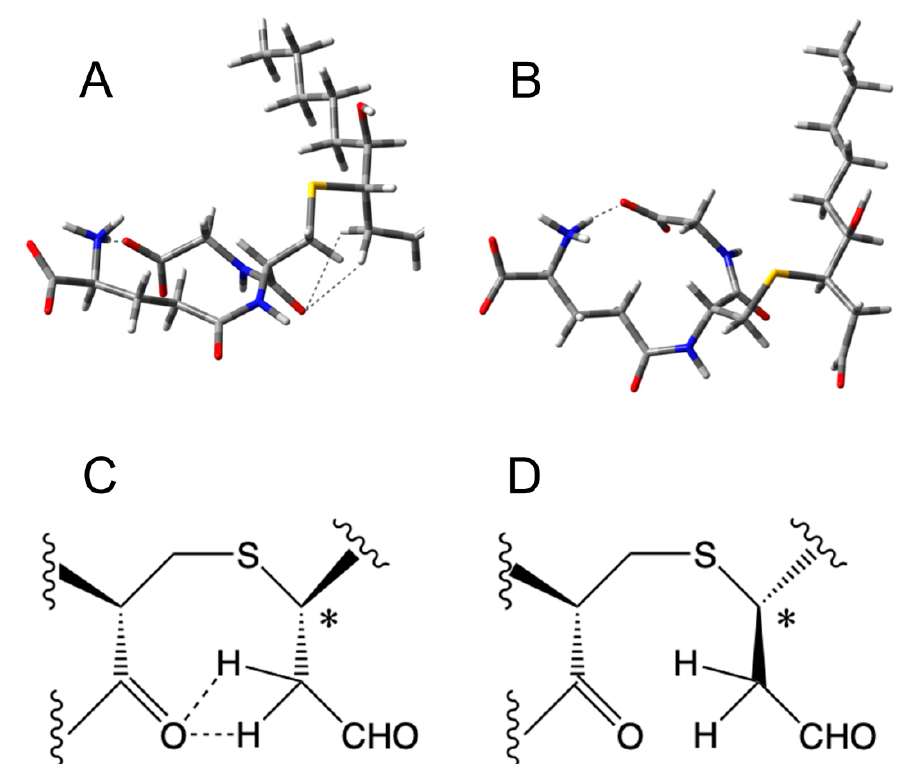
Figure 4. Structure of the open forms of GSHNE diastereoisomers. ( A ) The structure of 3 S ,4 R-GSHNE . The interactions between glutathione amino- and carboxyl-terminals and between the C2 acidic protons of the nonanal portion and the one amidic group of the glutathione moiety are shown. ( B ) The structure of 3 R ,4 R -GSHNE. The interaction between glutathione amino- and carboxyl-terminals is shown. ( C,D ) The di ff erent configurations of the chiral center (*) allow intramolecular hydrogen bonding when the involved groups are on the same side of the plane for 3 S ,4 R-GSHNE ( C ), and prohibit bonding when the involved groups are on opposite sides of the plane for 3 R ,4 R -GSHNE ( D ). Only relevant parts of the molecules are shown in the last two panels.